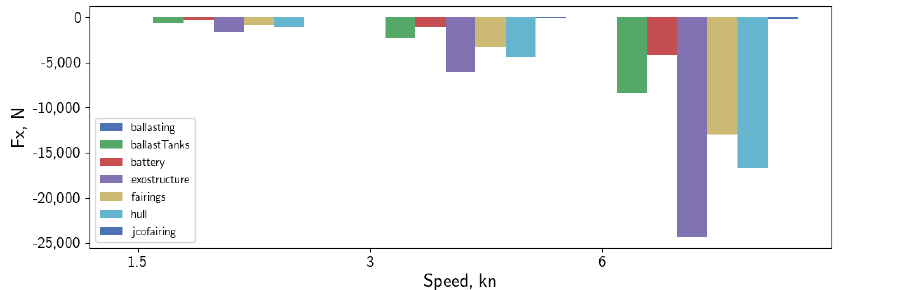
Figure 10. Resistance of individual patches of Geometry 3 when sailing at the free surface (0 m depth).